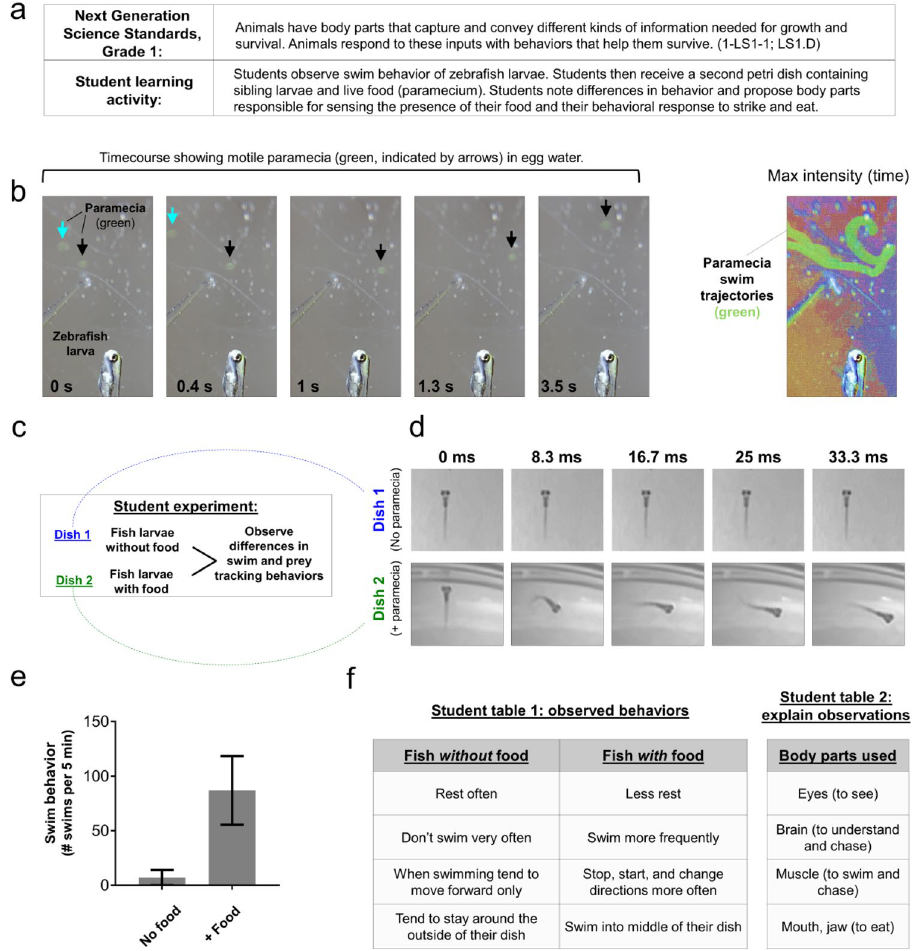
Figure 7. Grade 1 student learning activity addressing NGSS core ideas of the animal body parts needed for survival. ( a ) Description of NGSS standard and proposed student activity. ( b ) Timecourse (left, gray image series) shows two motile paramecia (blue and black arrows) in the same field of view as a paralyzed zebrafish larva (shown for scale comparison). Color image at right is a maximum intensity time projection, which plots the brightest pixel from each frame in a timelapse video and thereby marks the trajectory of each paramecium (green). Color was added to this image using the texturizer feature in PowerPoint. ( c ) Outline for student learning activity comparing swim and prey tracking behavior between a dish containing zebrafish larvae without food (paramecium) versus siblings in the presence of paramecia. ( d ) Timecourse image series shows zebrafish larva in the absence or presence of paramecia in the petri dish. Note the relative lack of movement in controls (upper, dish 1) in comparison to the paramecia treated dish (lower, dish 2). The timecourse shown in ( d ) represents 33 ms. ( e ) Graph shows the difference in the frequency of fish larva (5 dpf) swim behavior between groups proposed in ( d ). N = 4 larvae per condition obtained in one independent experiment; bars show the mean ± standard error; P = 0.0911, paired two-tailed t-test. ( f ) Example of student observations comparing groups from panel ( d ), and proposing the body parts involved in the prey tracking behaviors. Images